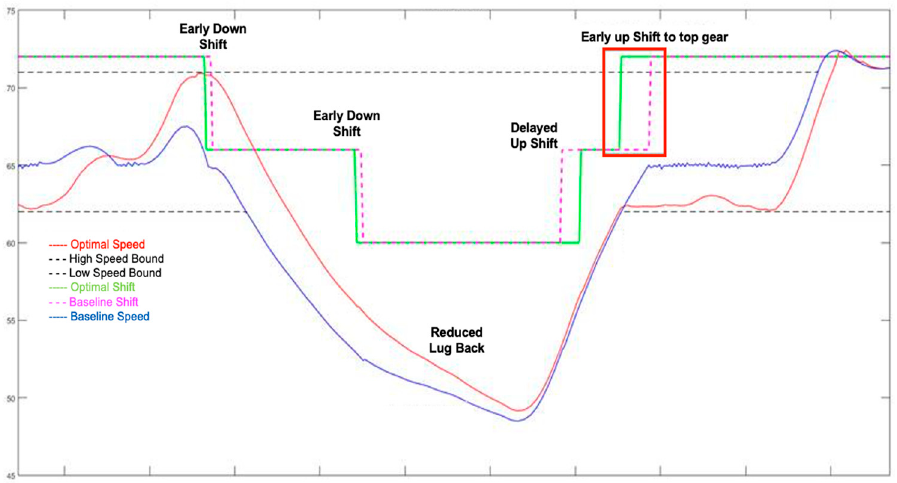
Figure 6. Predictive optimality in gear management. The problem shows the predictive gear shift.